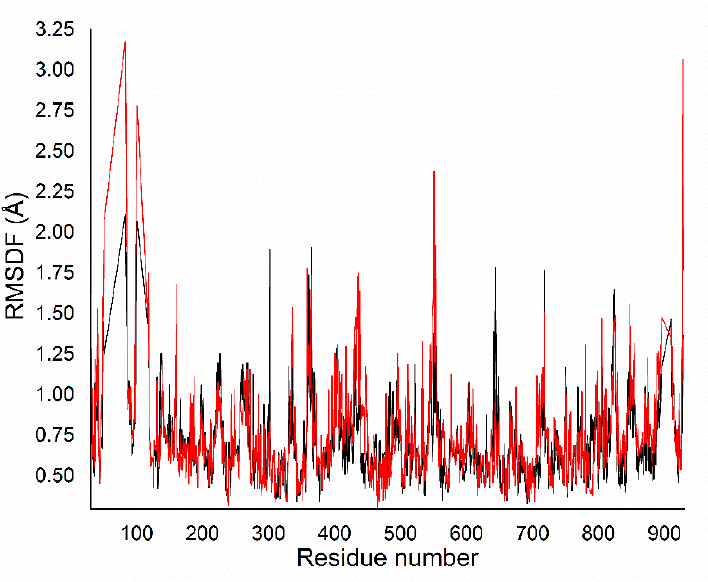
Figure 10. Root Mean Square Fluctuation (RMSF) for compound 6 (black line) and GS-441524 (red line).